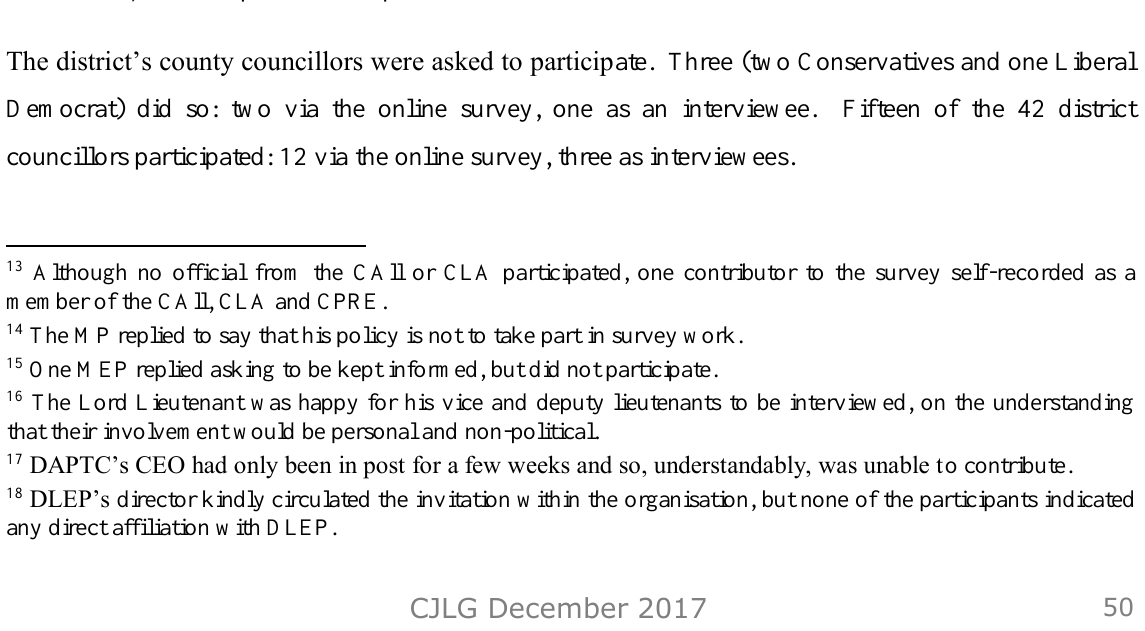
Asked to Participated participate 0